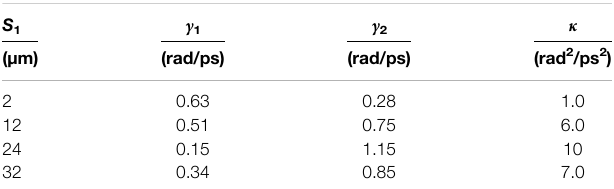
TABLE 1 | Parameters used in the coupled Lorentz model for the calculation of